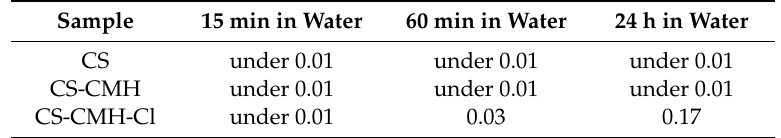
Table 1. Concentration of the free chlorine (mg / L) in aqueous extract of chitosan (CS) materials.